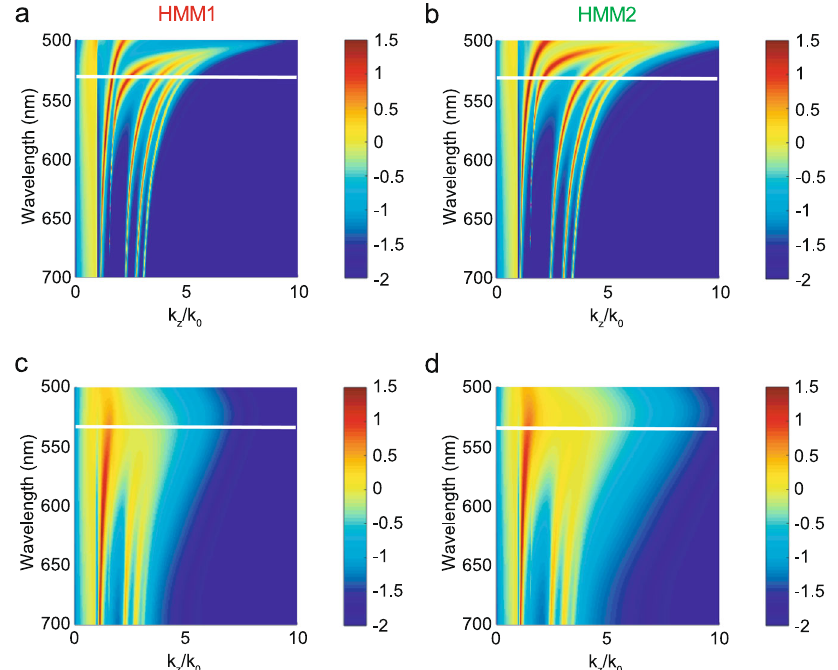
Fig. 4 k-space dissipated power density. The k -space dissipated power density without considering loss effect for the a HMM1 and b HMM2. c , d Corresponding dissipated power densities with considering the loss effect. The white line is the emission center of PNCs at the wavelength of 530 nm. For the HMM2 sample, the k -space dissipated power density shows stronger coupling of the emitter to HMM supported plasmonic